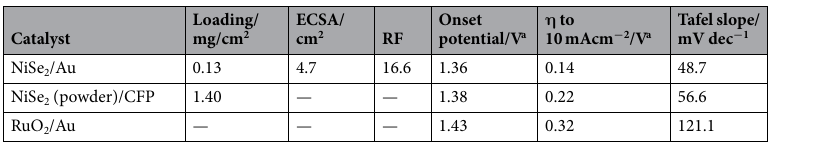
Table 1. Electrochemical parameters of the NiSe 2 catalysts measured in 1.0 M KOH. a Potential reported with respect to